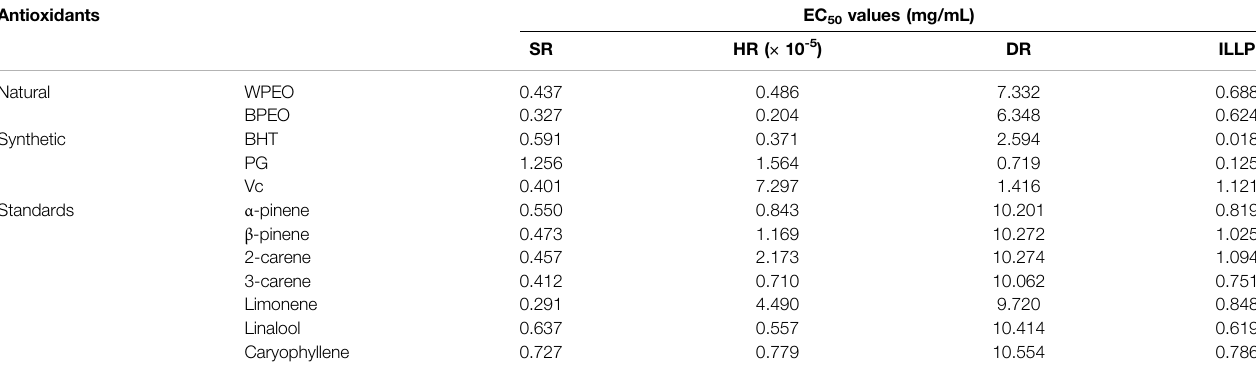
TABLE 1 | EC 50 values (mg/mL) of WPEO, BPEO, synthetic antioxidants (BHT, PG, and Vc) and seven standards (SR, superoxide radical scavenging activity; HR, hydroxyl radicalscavengingactivity;DR,DPPHradicalscavengingactivity;ILLP,inhibitionoflipoproteinlipidperoxidation;WPEO,whitepepperessentialoil;BPEO,blackpepper essential oil; BHT, butylated hydroxytoluene; PG, propylgallate; Vc, ascorbic acid). Antioxidants